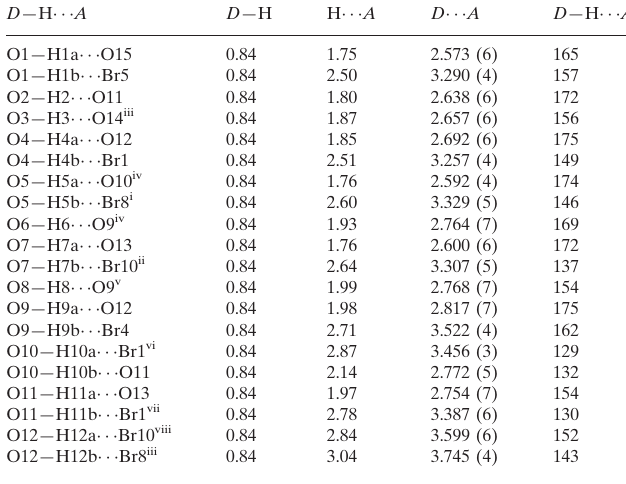
Hydrogen-bond geometry (A˚ , (cid:3)